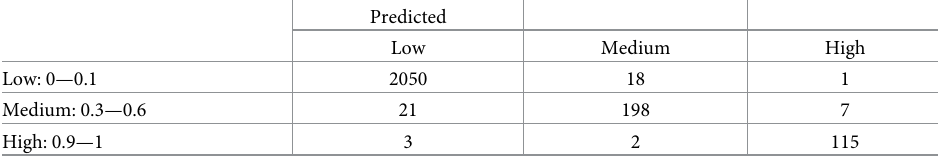
Table 3. Multinomial logistic regression binned with respect to fibrotic pathology grades: Low (0–0.1), medium (0.3–0.6), high (0.9–1). Predicted Low Medium High